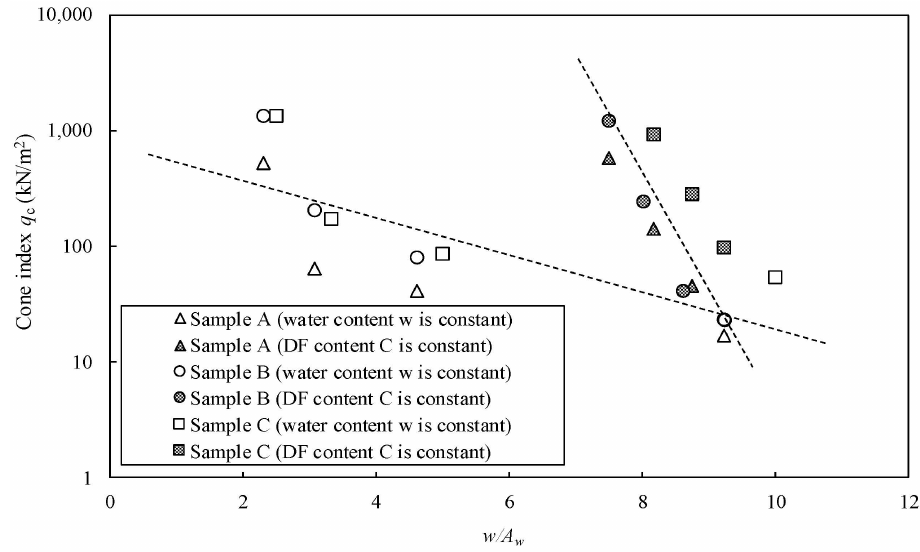
Figure 9. Cone index q c vs. w / A w ratio on the stabilized clays by DF in three types of Kumamoto